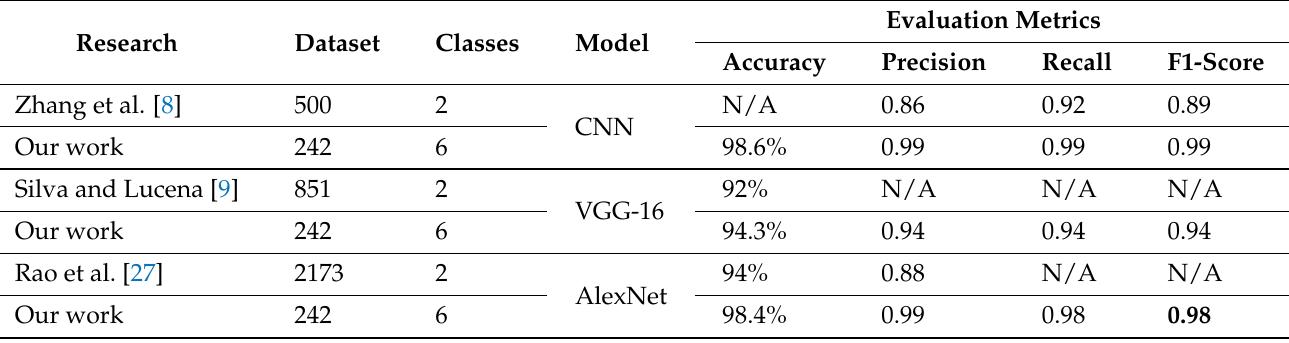
Table 8. Comparison with previous